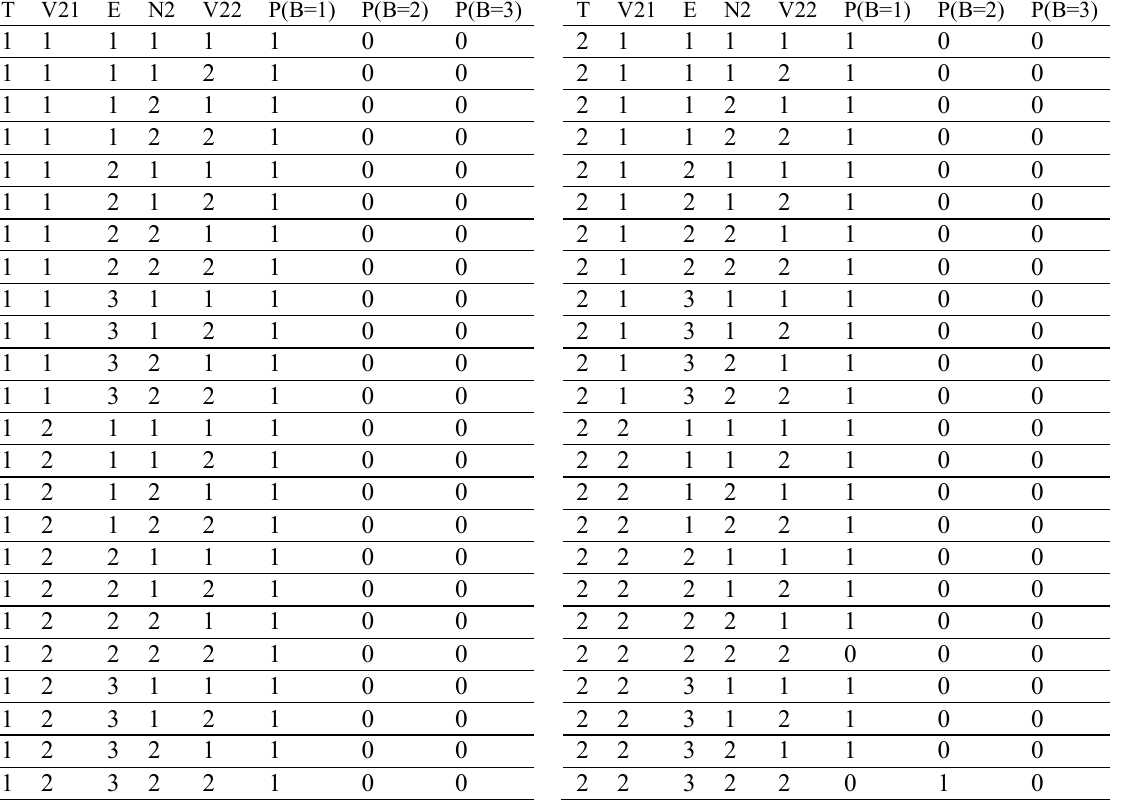
Table 14. States related to node